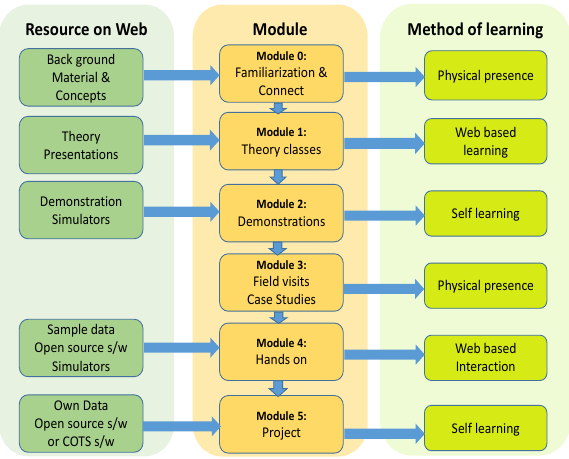
Fig 5. Multi-level training implementation